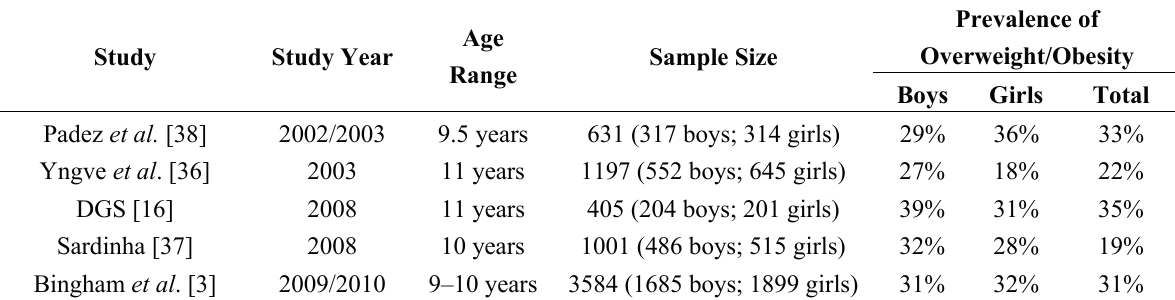
Table 1. Summary of overweight/obesity prevalence in 9–11 year-old Portuguese children used in the